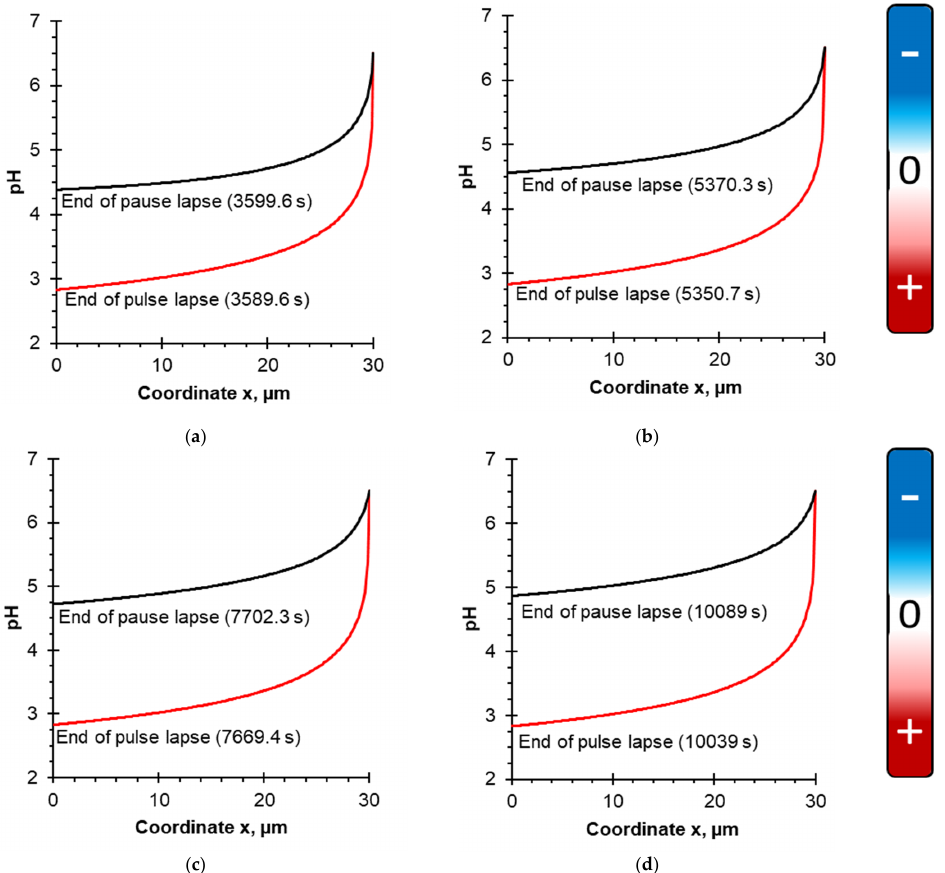
Figure 4. pH evolution of the caseinate solution vs the coordinate. Calculations are performed for δ = 30 µm and the following PEF modes: ( a ) 10 s–10 s at the end of the pulse lapse (3589.6 s) and pause lapse (3599.6 s); ( b ) 10 s–20 s at the end of the pulse lapse (5350.7 s) and pause lapse (5370.3 s); ( c ) 10 s–33 s at the end of the pulse lapse (7669.4 s) and pause lapse (7702.3 s); ( d ) 10 s–50 s at the end of the pulse lapse (10,039 s) and pause lapse (10,089 s). The steady-state condition is considered. To